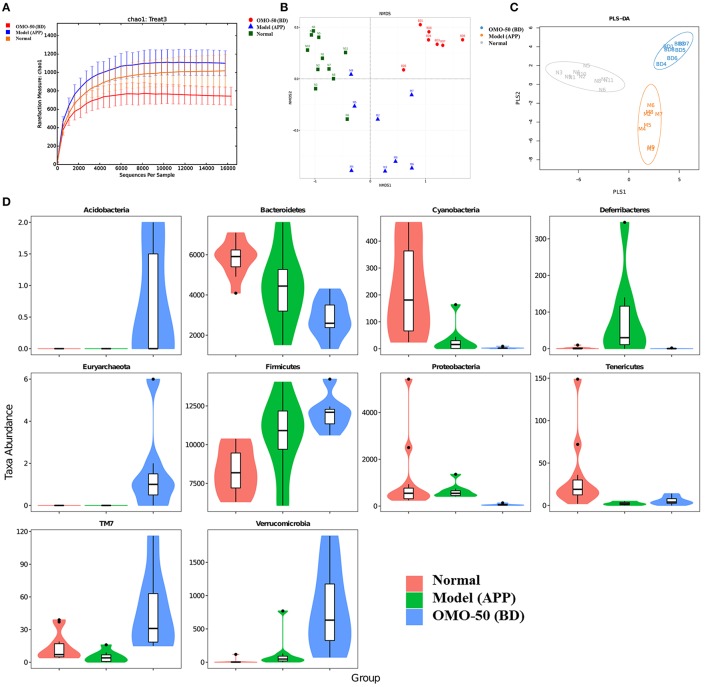
Effects of OMO on the gut microbiota of the APP/PS1 transgenic mice, as determined from fecal samples. The rarefaction curve (A), the results of the NMDS analysis (B), PLS-DA results (C), classification and abundance of fecal contents at the phylum level (D), and the results of 16S rRNA sequencing of the gut microbiota using an Illumina MiSeq sequencing system are shown. N denotes the C57 group, M represents the APP/PS1 transgenic group, BD denotes the 50 mg/kg OMO-treated group, and BH indicates the 100 mg/kg OMO-treated group.